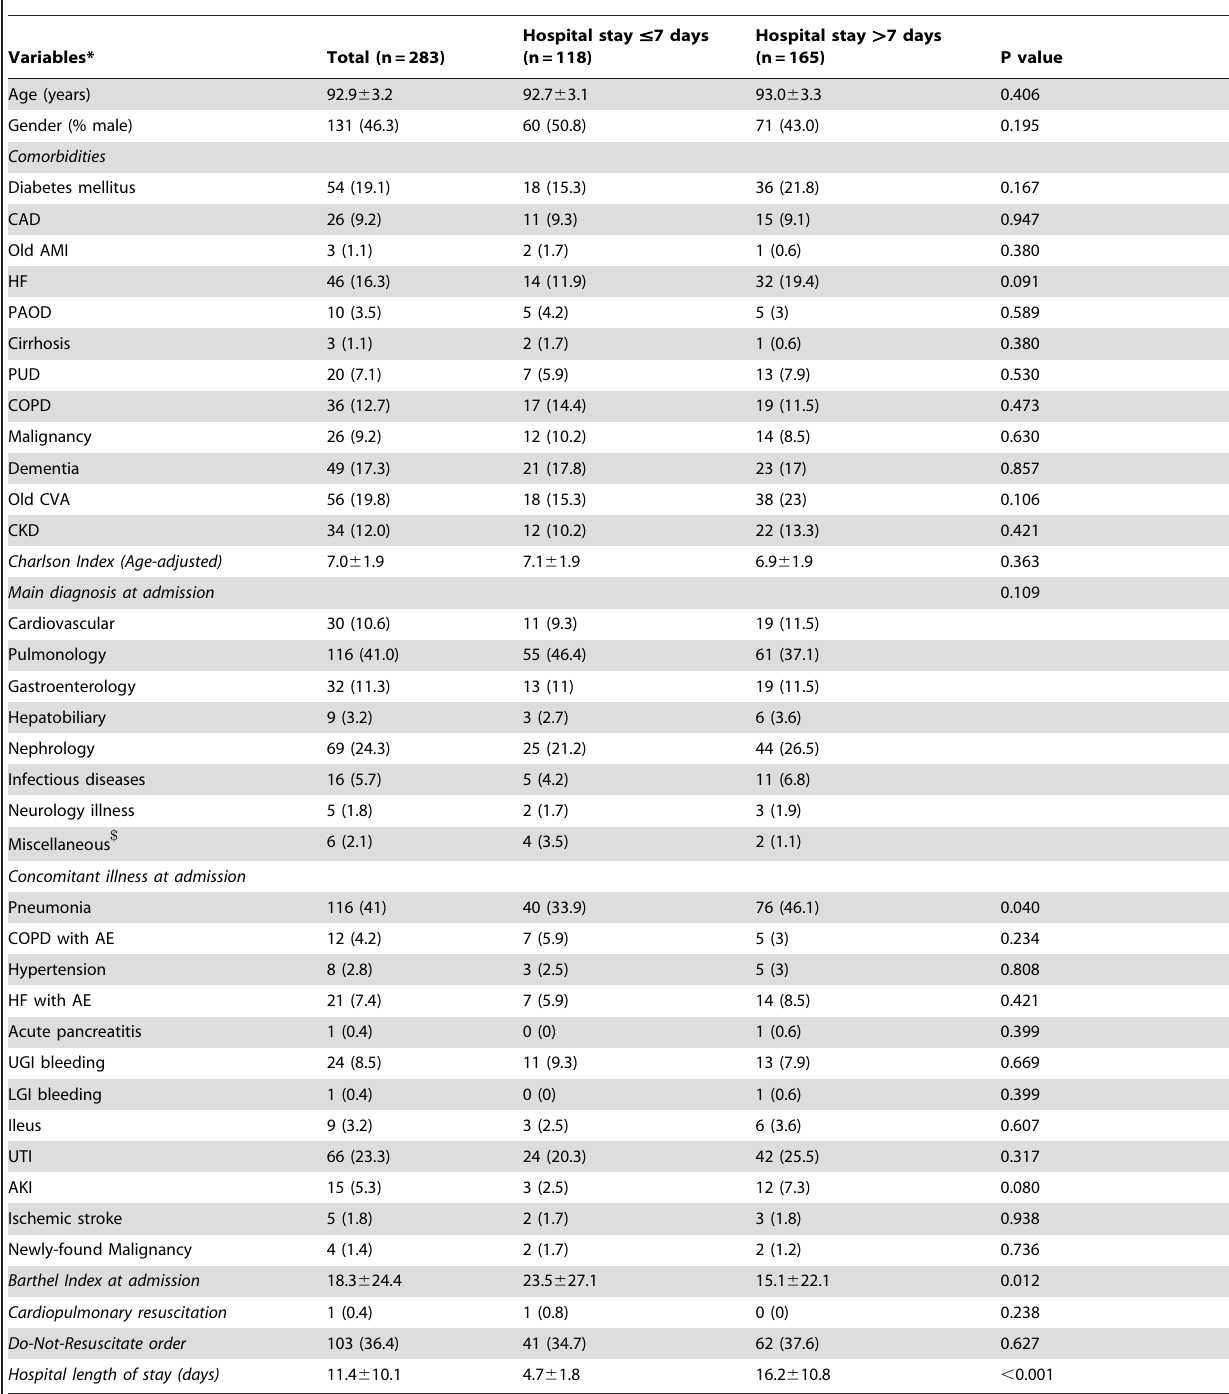
Table 2. Clinical features of admitted nonagenarians by length of hospital stay (percentage in